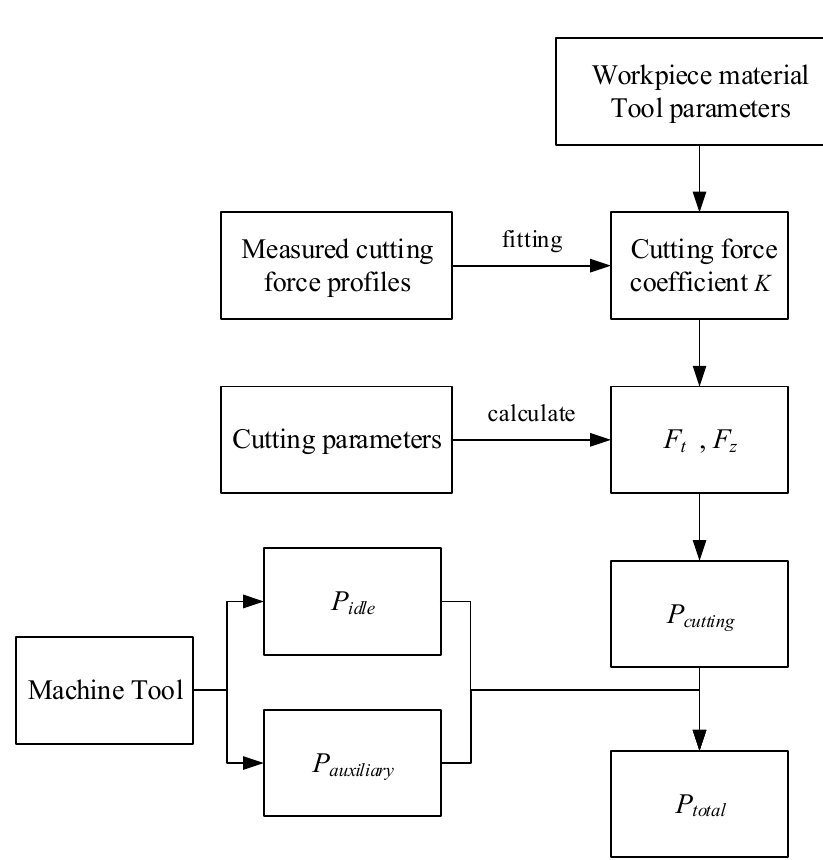
Figure 7. Flowchart of the drilling process energy consumption calculation.